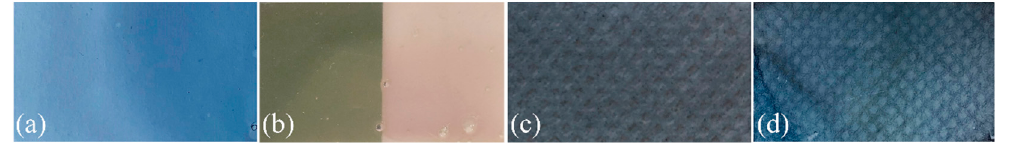
Figure 6. The PVA–AgNPs thin film: sample B ( a ) and the sample I ( b ); nanofibers of non-woven textile prepared by electrospinning ( c ) and dip-coating ( d ) of sample B.